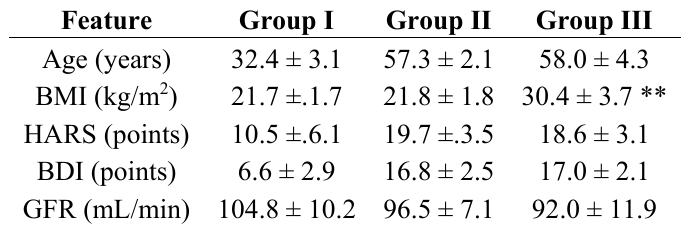
Table 2. General characteristic of women enrolled in the study. Results of the mean value and standard deviations; ** p <